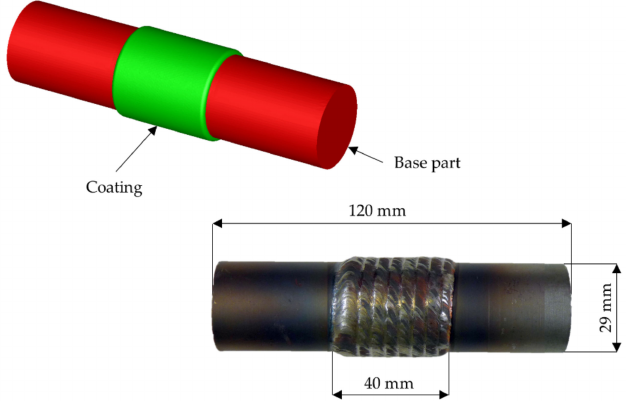
Figure 2. FEA-model ( above ) and real picture ( below ) of the geometry used for the